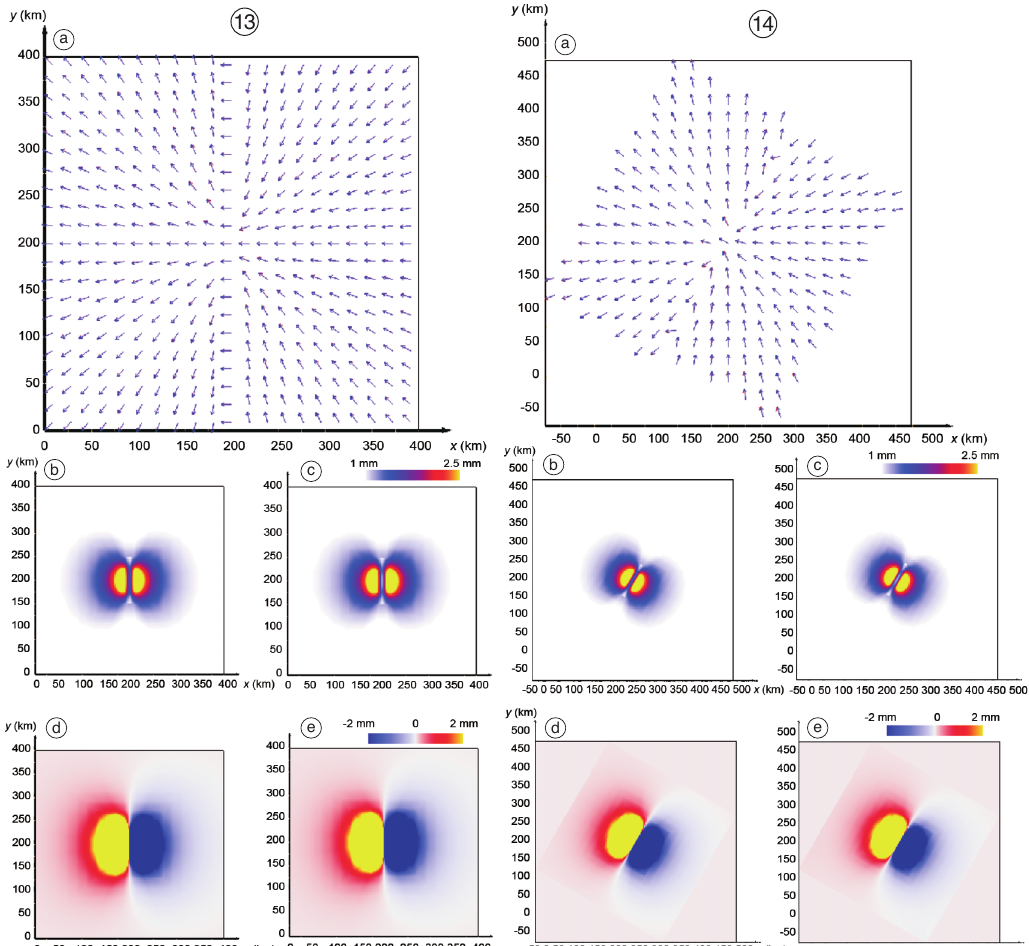
Fig. 13a-e. Same as fig. 11a-e but for a normal dip slip with δ = 90° and φ = 0°. Fig. 14a-e. Same as fig. 11a-e but for a normal dip slip with δ = 90° and φ =